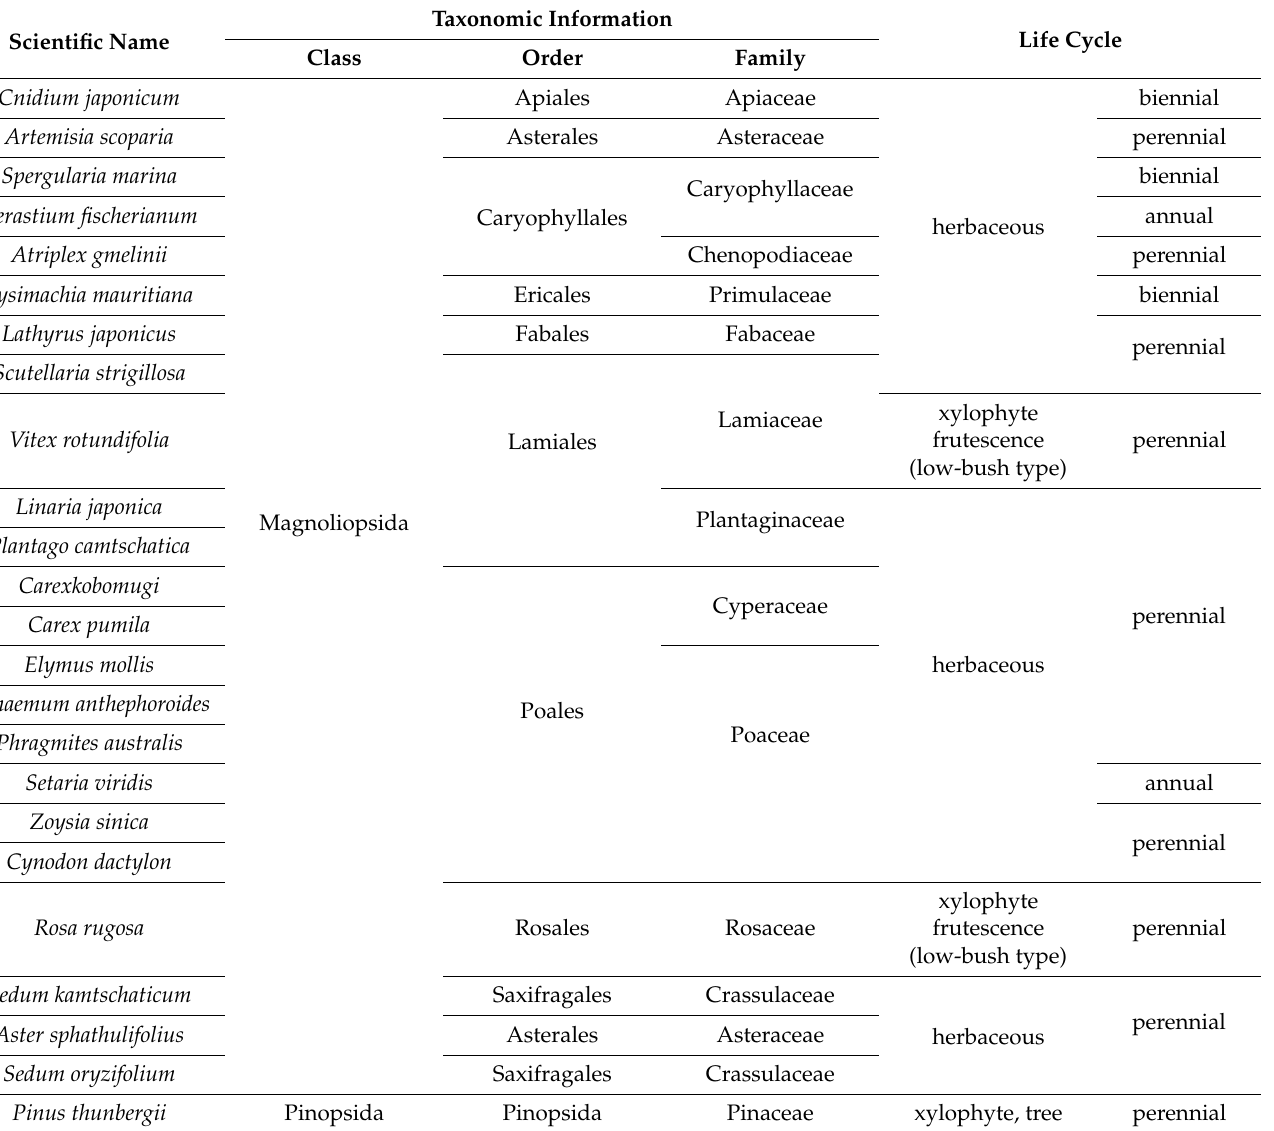
Table 1. Classification and identification of halophytes native to coastal